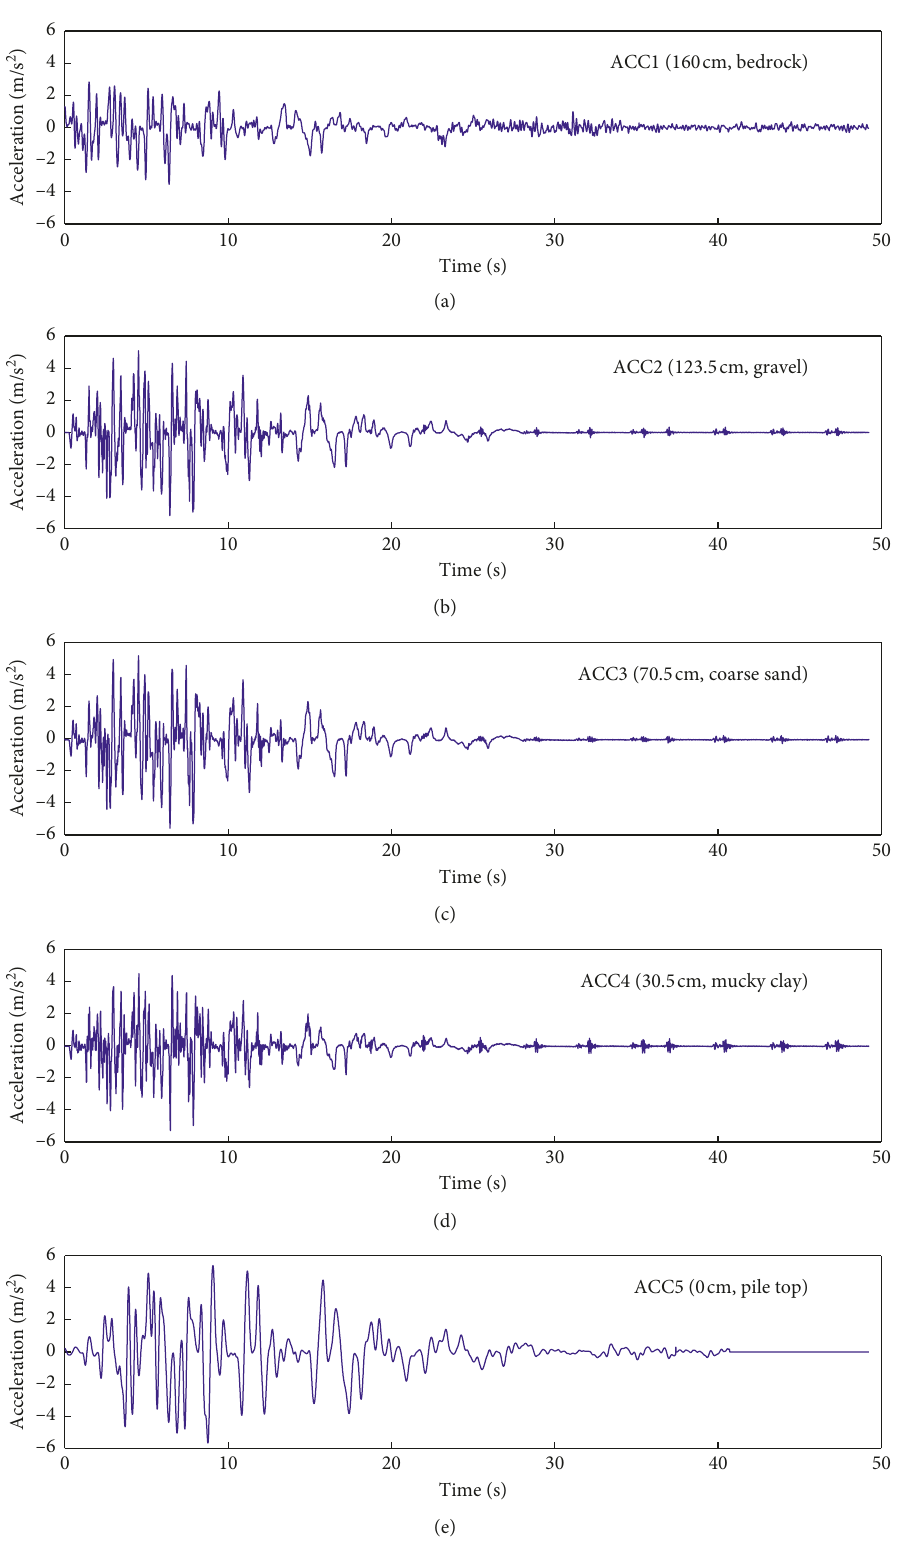
Figure 13: Time histories of pile acceleration for a seismic intensity of 0.35g: (a) ACC1; (b) ACC2; (c) ACC3; (d) ACC4; (e) the seismic intensity increases, the maximum relative dis- 4.2. Horizontal Displacement of the Pile. Figure 14 shows the placement at the top of the pile increases approximately maximum relative horizontal displacements at the top of the linearly. The maximum relative displacement ranges from pile for different seismic intensities from 0.15 g to 0.60 g. As